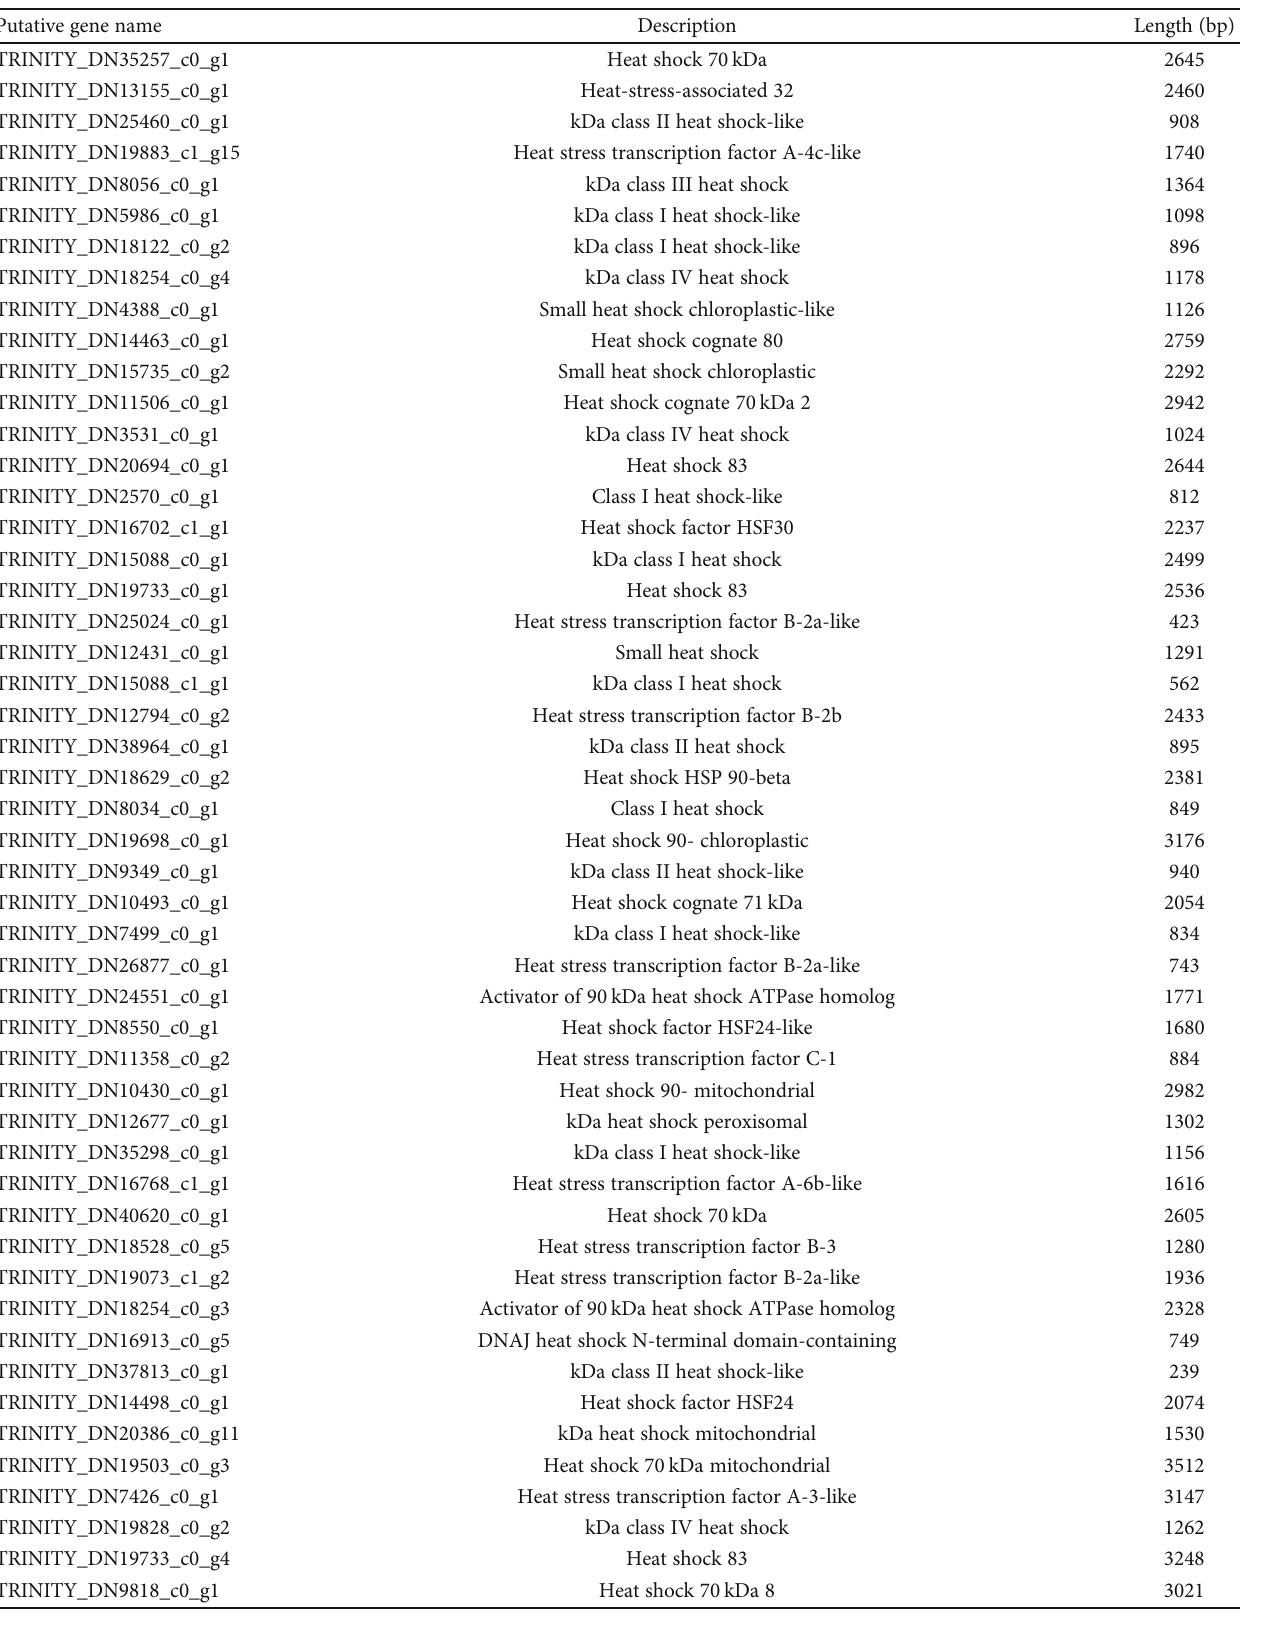
Table 2: Examples of upregulated heat-responsive genes in